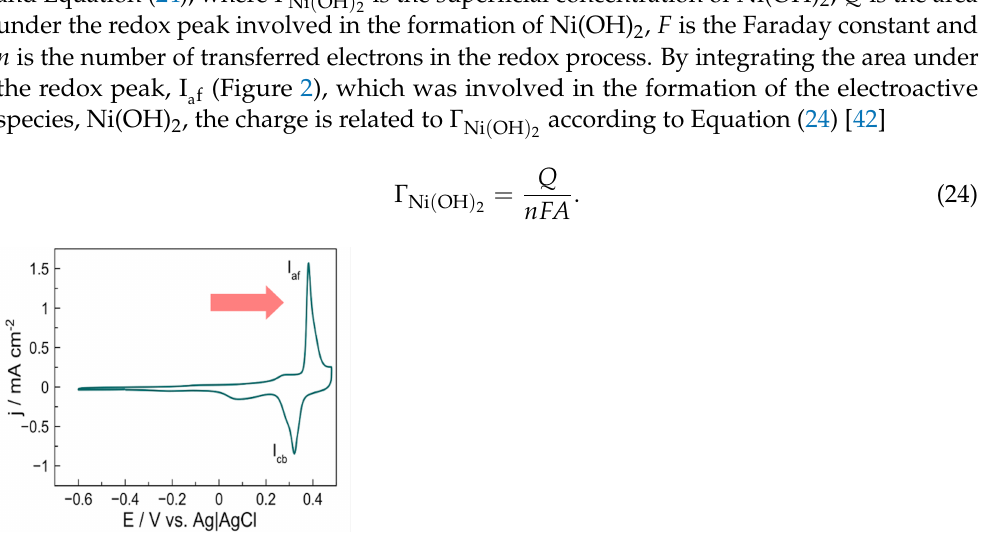
Figure 2. Cyclic voltammetry for nickel deposited in a gold electrode in 1M KOH. Modified from